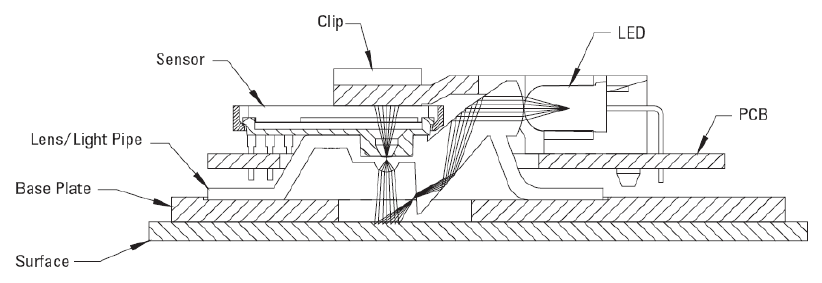
Figure 4. Sectional view of assembly components for the ADNS-3088 sensor (courtesy of Avago).